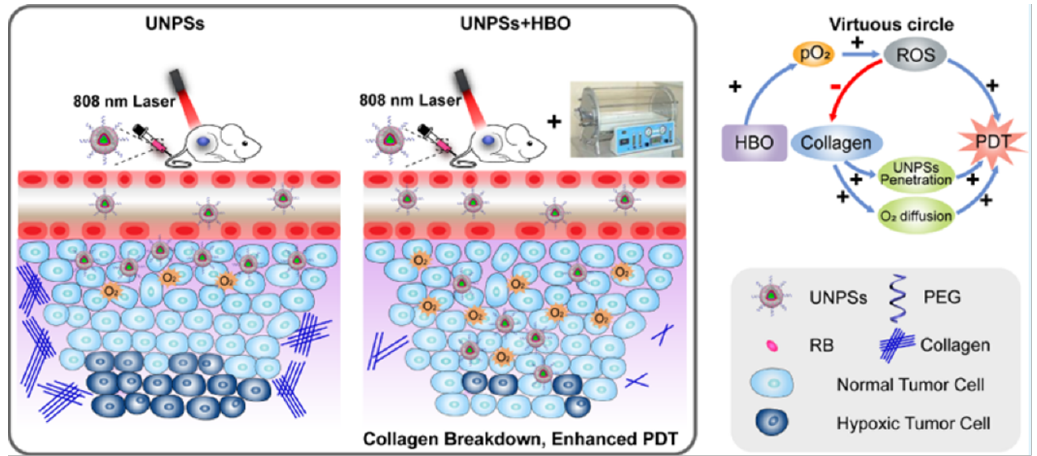
Figure 13: Schematic Illustration of Synergizing UNPSs with or without HBO for Remodelling Collagen in the ECM To Achieve Better Oxygena- tion and Deeper Penetration of Nano-PSs for Enhanced Photodynamic Cancer Therapy [83].